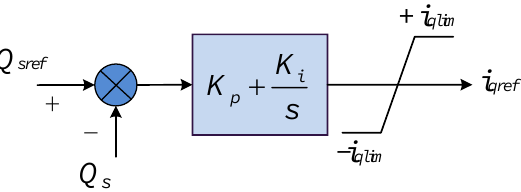
Figure 4. The detailed outer controls of the reactive power control.